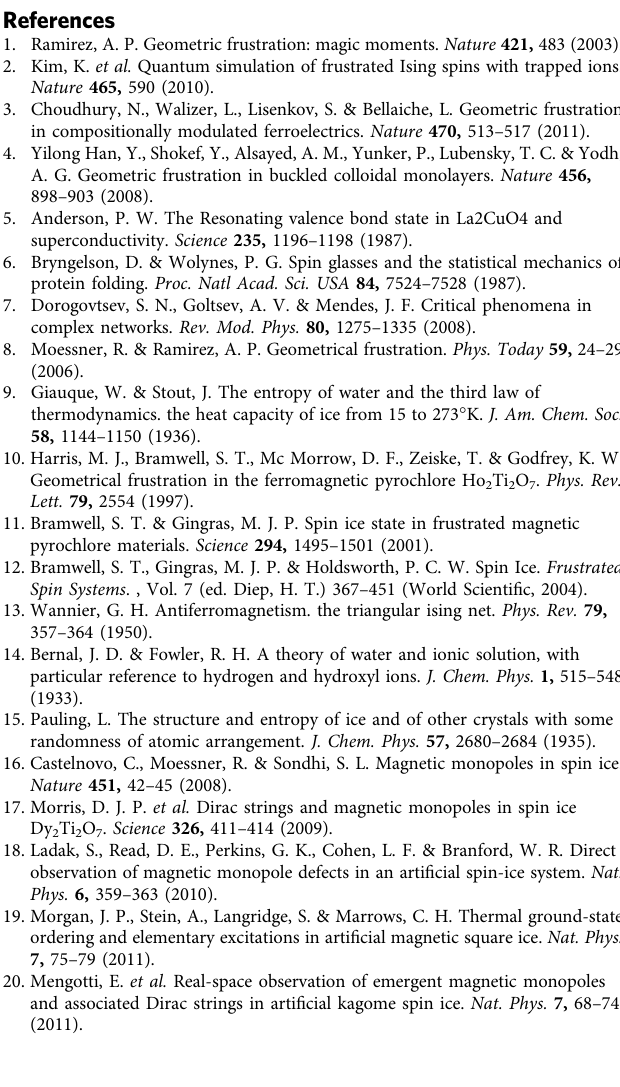
However, the height of the central hill h connecting the two circular traps in the double wells is modified to match the experimental data. Small discrepancies can arise in the hill elevations in photolithographic platforms realized during different fabrication process. First, to validate our theoretical model, we perform initial simulation to match the displacement observed between isolated pair of particles placed within two double well-oriented in a square and honeycomb lattice. The good comparison between experimental data (scattered points) and simulation results (continuous lines) is shown in Supplementary Fig. 7b. The step-like beha- viour of the pair distance observed for the blue and green curves is due to the barrier overcoming of one particle. This process is energetically more expensive for isolated particles, reflecting that in the colloidal spin ice system the particle arrangement is a true collective effect rather than resulting from local energy